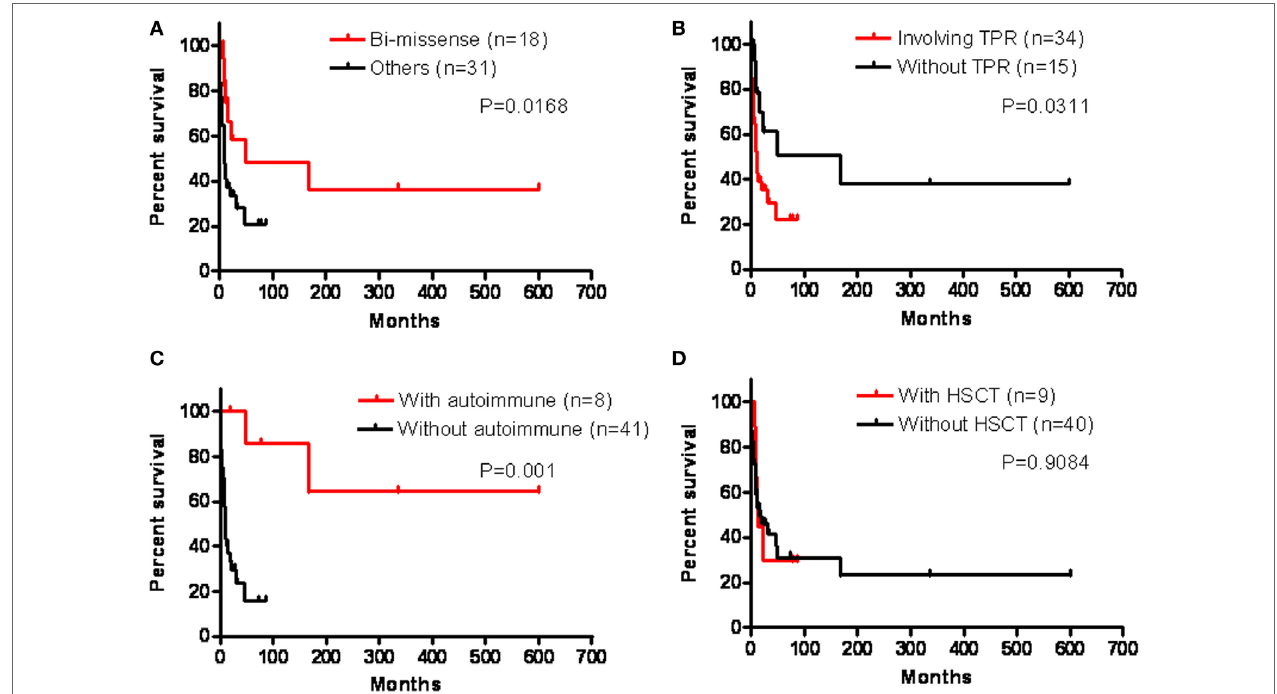
FigUre 6 | We analyzed their prognosis in the presence of genetic bi-missense mutations (a) , tetratricopeptide repeat (TPR) domain involvement (B) , autoimmune disorders (c) , and hematopoietic stem cell transplantation (HSCT) (D) by Kaplan–Meier analysis, which revealed a significantly better prognosis in those with bi-missense mutations ( p = 0.0168), without TPR domains ( p = 0.0311), and with autoimmune disorders ( p = 0.001), but not significantly in those receiving HSCT ( p =